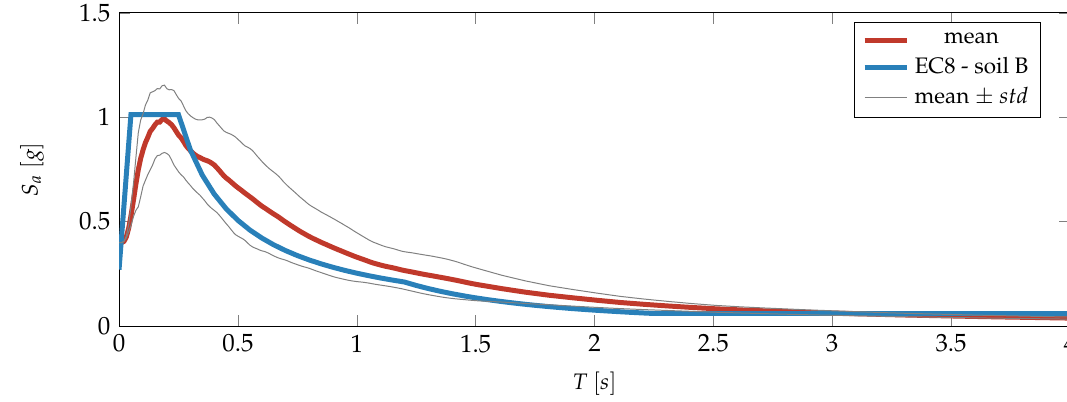
Figure 2. Mean spectrum of the 942 ground motions retrieved from the COSMOS database (red line) with its standard deviation (light grey lines). The blue line represents the EC8 elastic